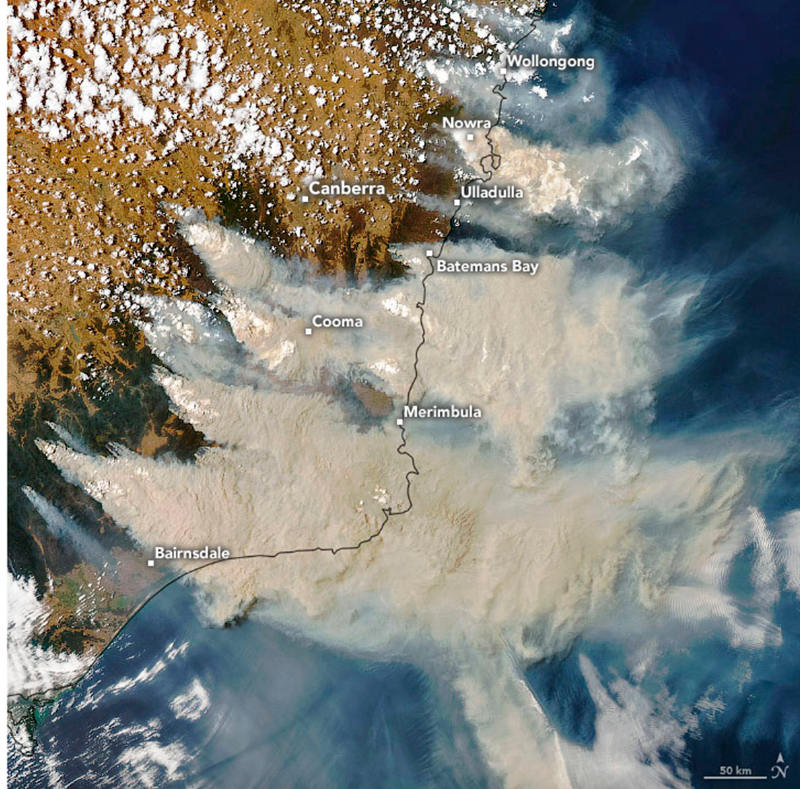
Figure 2. Extreme fire events on the 4 January 2020 over southeast Australia as shown by the Moderate Resolution Imaging Spectroradiometer (MODIS) on NASA’s Aqua satellite. In the image, smoke (tan in colour) and clouds (bright white) can be seen, while the white patches above the smoke may be pyrocumulonimbus clouds (source: Earth Observatory of NASA, available at https://earthobservatory.nasa.gov/images/146110/fires-and-smoke-engulf-southeastern-australia accessed on 30 April 2022, 16:49 Australian EST).